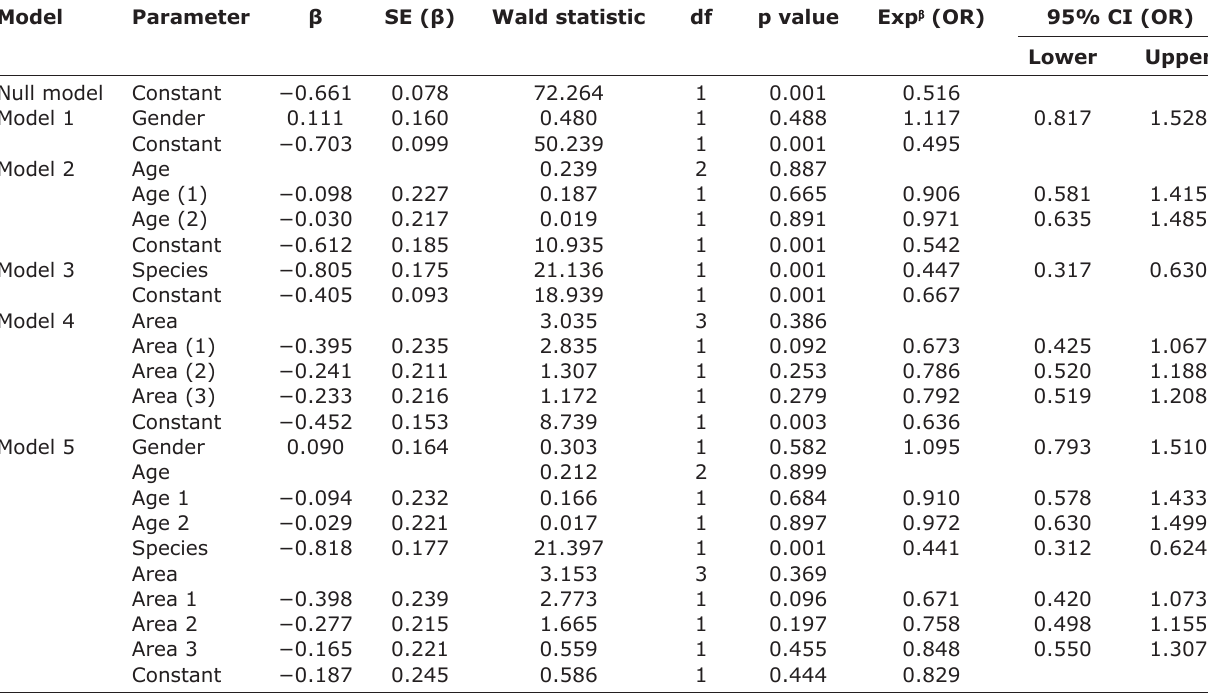
Table-5: Univariable and multivariable Logistic regression models for modeling and predicting BVDV seroprevalence.